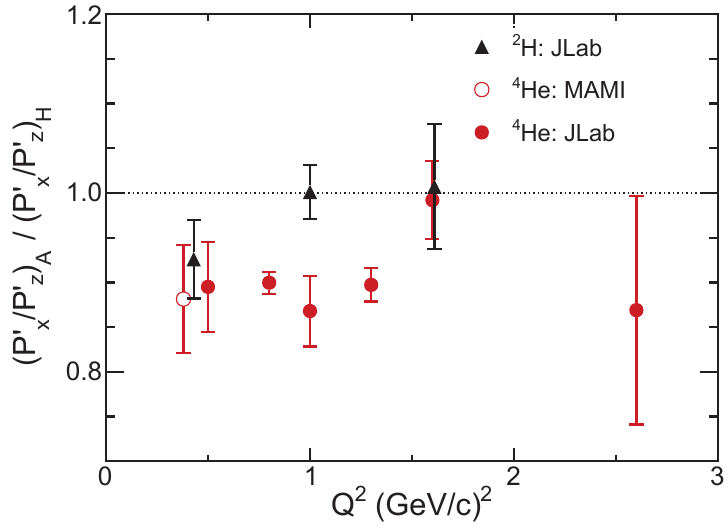
/ P (cid:2) ) A , for 2 H( e , e (cid:2) p ) n (triangles) from [23] and for 4 He( e , e (cid:2) p ) 3 H (circles) x z